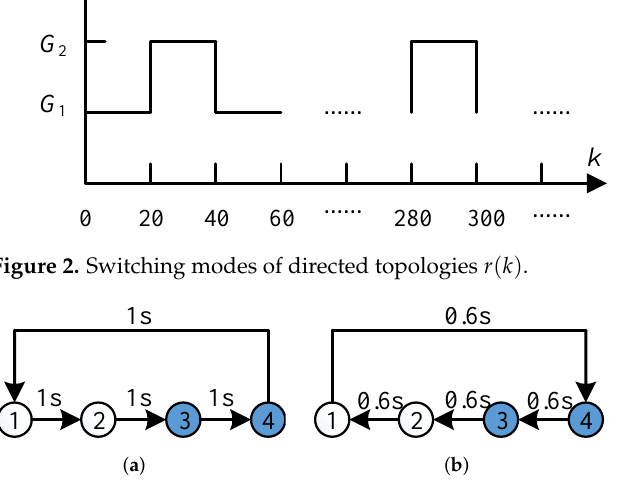
Figure 3. Interactive topologies of heterogeneous time-delay MAS (1). ( a ) G 1 , ( b ) G 2